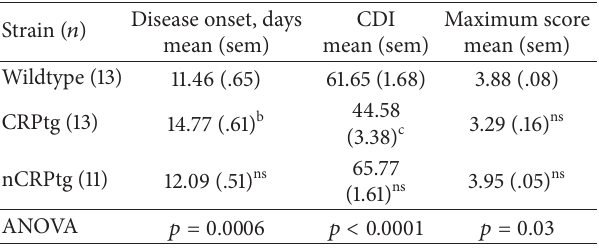
Table 1: The outcome of EAE in wildtype and human